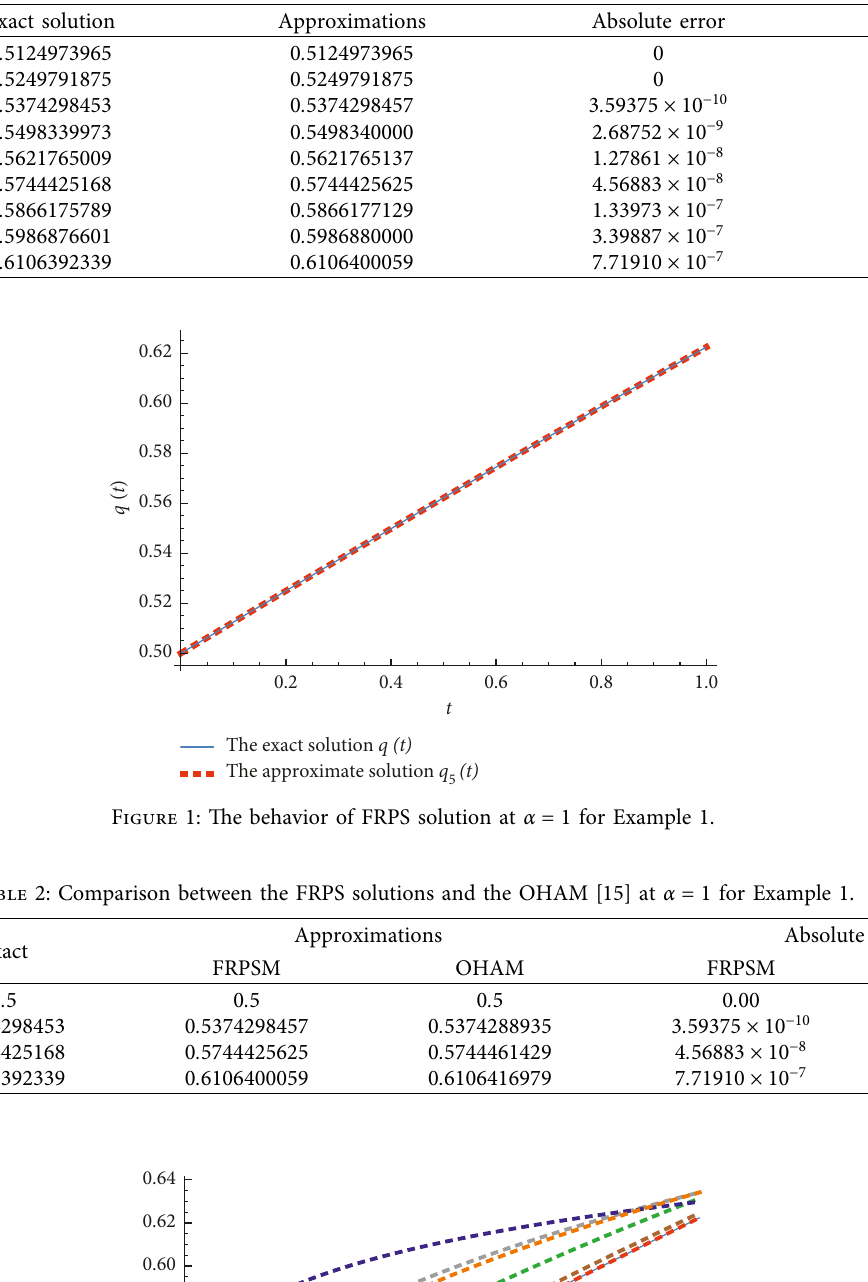
Table 1: Numerical results of 5 th FRPS at α � 1 for Example 1.